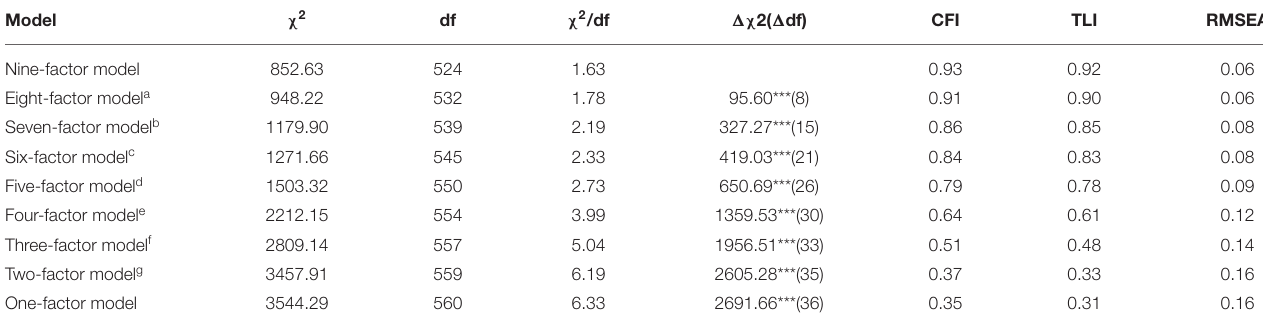
TABLE 1 | Confirmatory factory analyses.